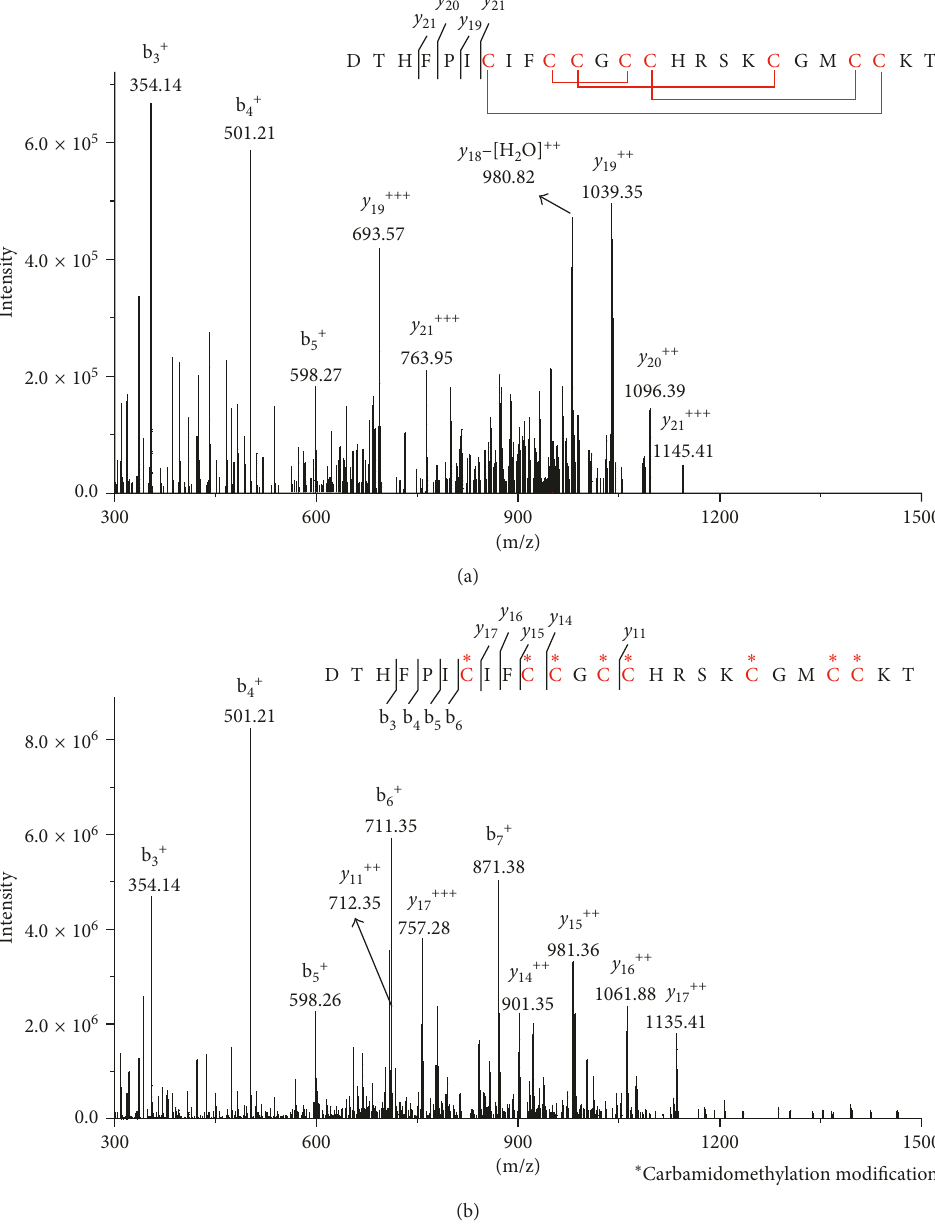
Figure 1: MS/MS spectrum of hepcidin-I and hepcidin-M. (a) is the MS2 spectrum for 558.6m/z ( z (b) is for 651.8m/z ( z 5) derived from the hepcidin-M. The cysteine (C) amino acid sequence of red color indicates disulfide bond and (cid:31) carbamidomethylation position in (a) and